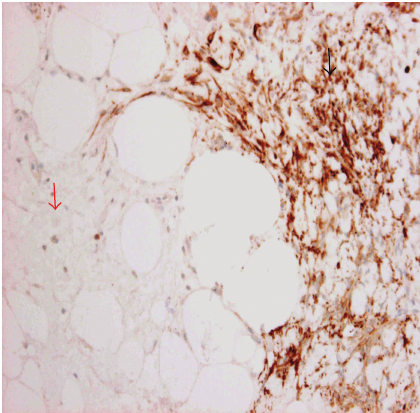
Figure 4: Mammary myofibroblastoma (MFB) with admixed but distinct spindle cell lipoma component. Desmin stains spindle cell of myofibroblastoma component (black arrow) but not spindle cell lipoma component (red arrow), immunoperoxidase, 400x.